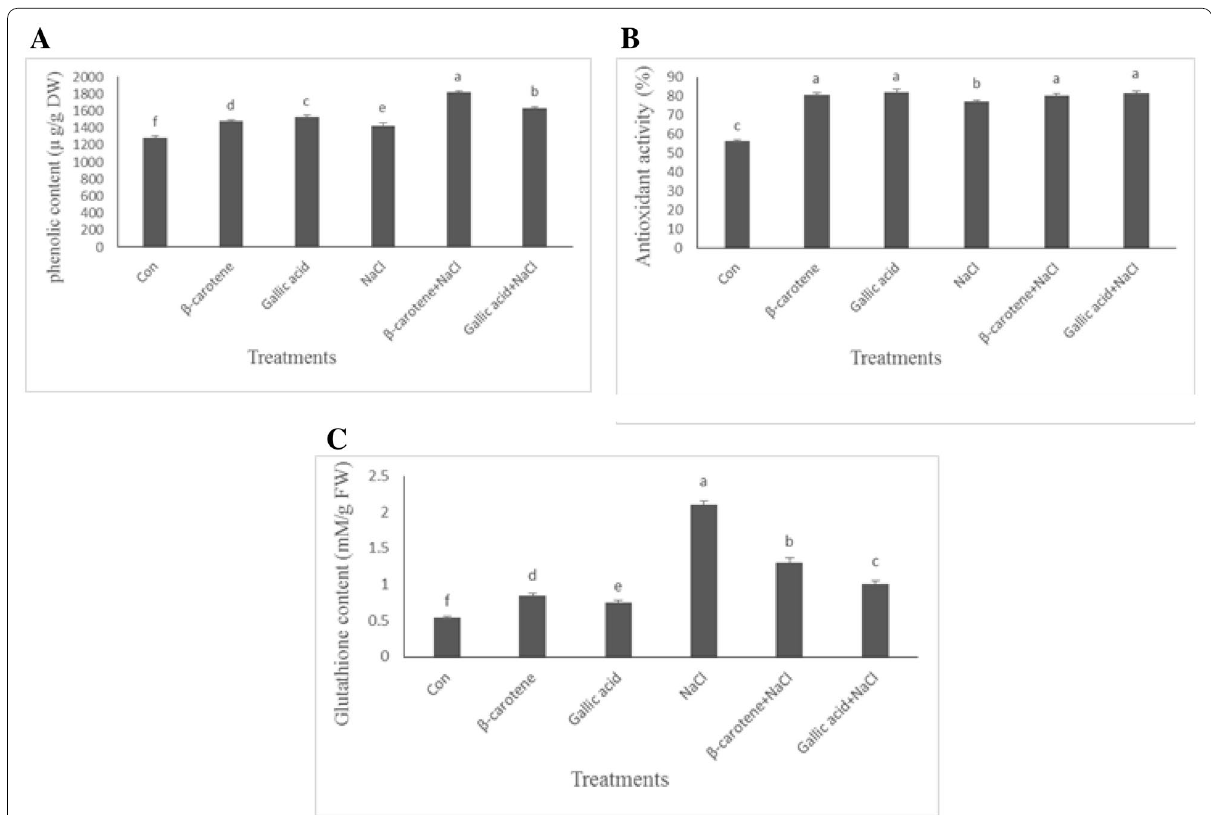
Fig. 5 Effect of β‑carotene and gallic acid, under saline and non‑saline conditions on the phenolic content ( A ), glutathione content ( B ), and DPPH radical scavenging activity ( C ) in Lepidium sativum seedlings. Columns with the same letters are not statistically different at 5% probability using Duncan’s